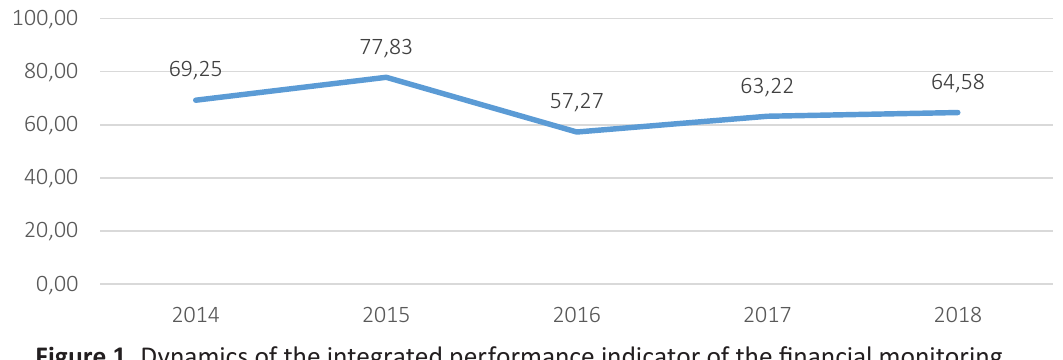
Figure 1. Dynamics of the integrated performance indicator of the financial monitoring of the Ukrainian banking system,